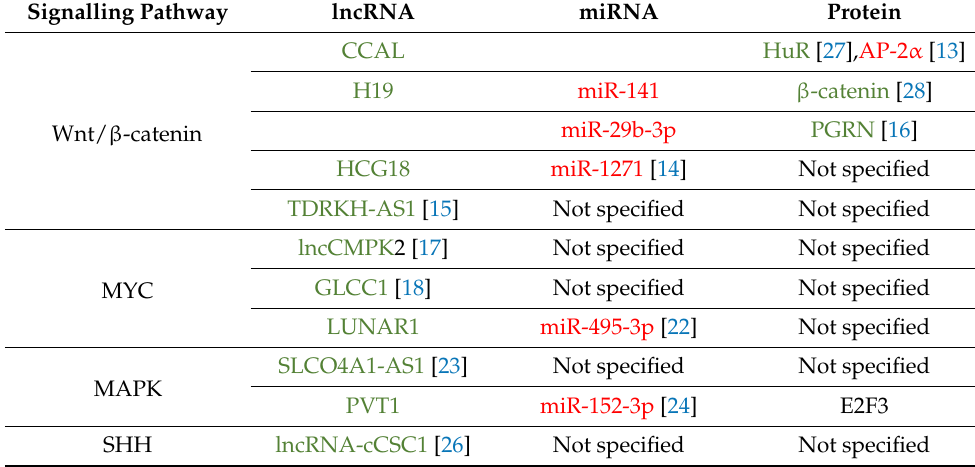
Table 1. ncRNA-related regulation of key signalling pathways. Signalling